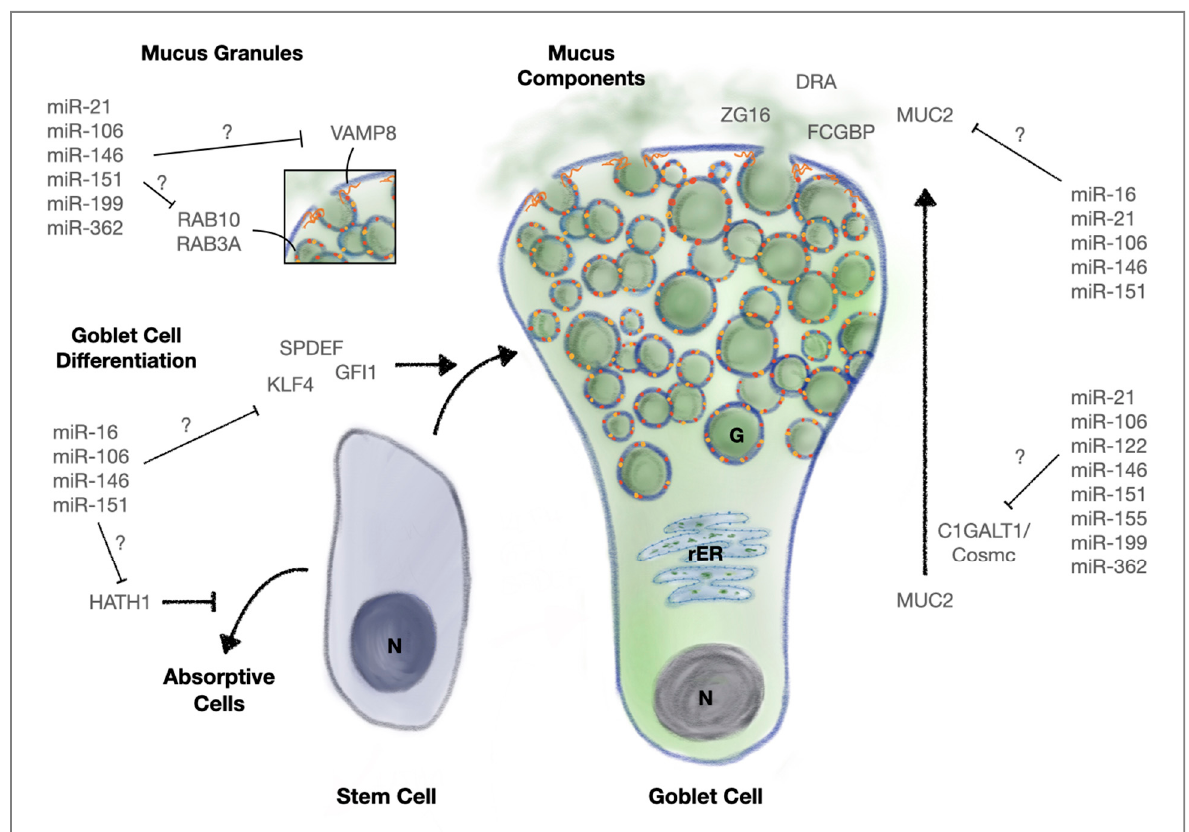
Figure 1. Predicted influence on the mucus layer by IBD-associated miRNAs through targeting goblet cell differentiation factors, mucus components and wall proteins of mucus granules. N: nucleus, rER: rough endoplasmic reticulum, G: mucin granules.